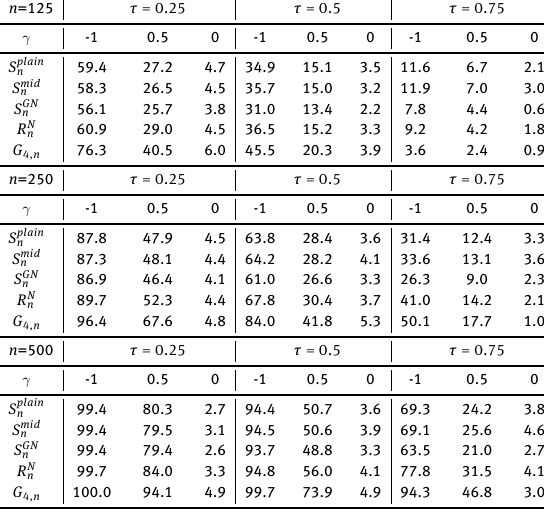
Table 7: Percentages of rejection at a 5% significance level, as estimated from 1000 replicates, for the tests based on S plain n , S mid n , S GN n , R N n and G 4, n under the Skew t-student copula with ν = 4 degrees of freedom, in dimension 2 . n =125 τ =